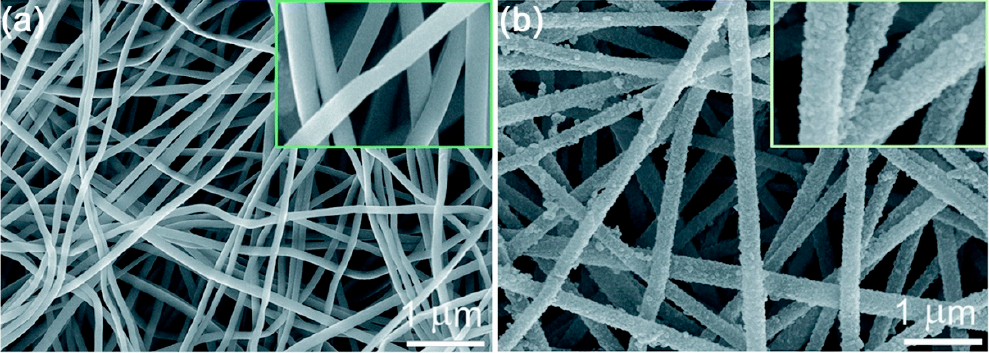
Figure 12. SEM image of ( a ) H 3 BTC/PAN filter and ( b ) PAN@MIL-100 (Fe) filter. Reproduced and adapted from Ref. [59]; Copyright (2019), RSC Journal of Materials Chemistry A.